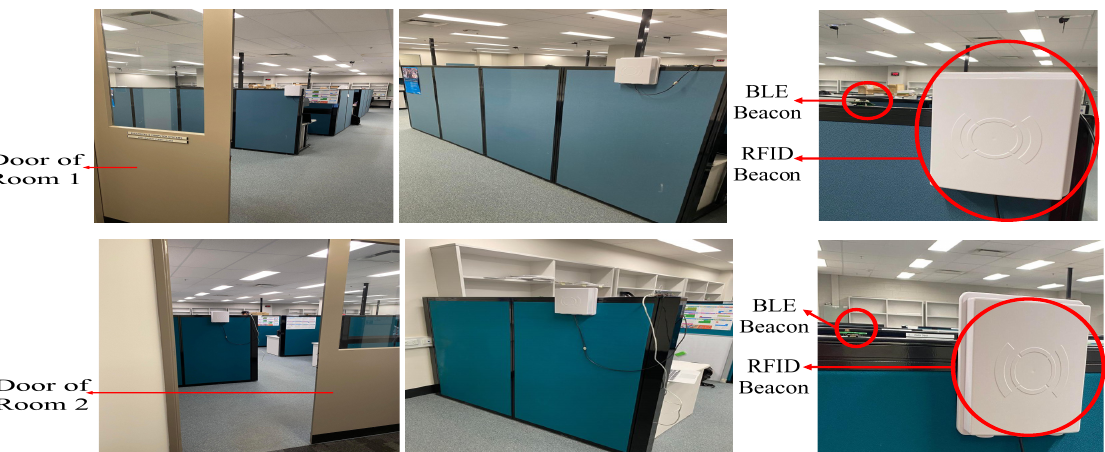
Figure 21. The setting for testing the two system together in Monash University. The first row shows the pictures of the first room and the second row presents the second